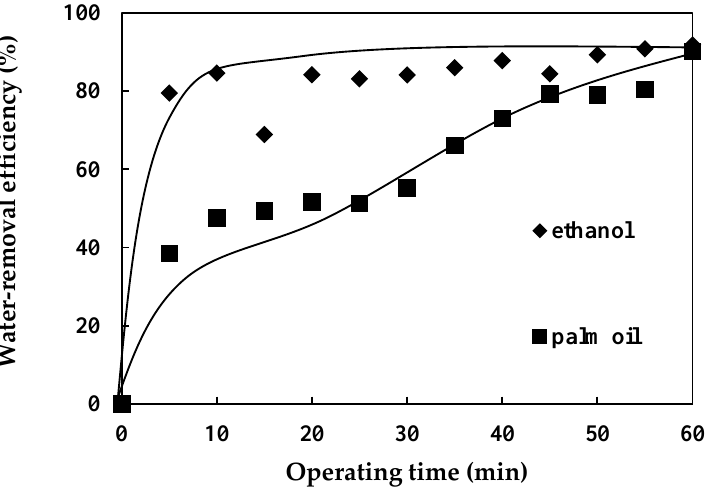
Figure 8. Comparison of the changes in water-removal efficiency with operating time between palm oil and ethanol by molecular sieves with rotary shaking.